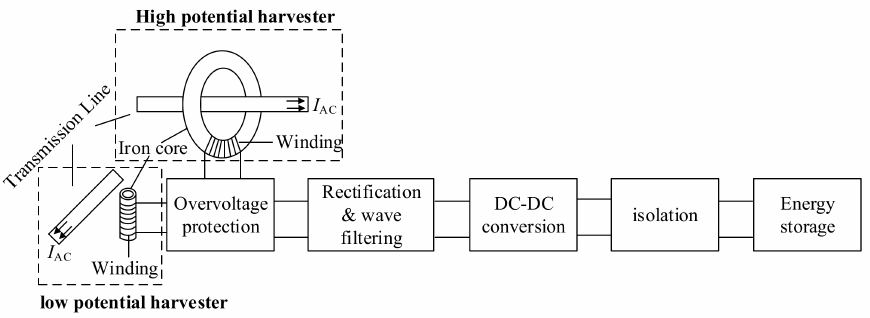
Figure 2. Schematic diagram of a magnetic energy harvesting